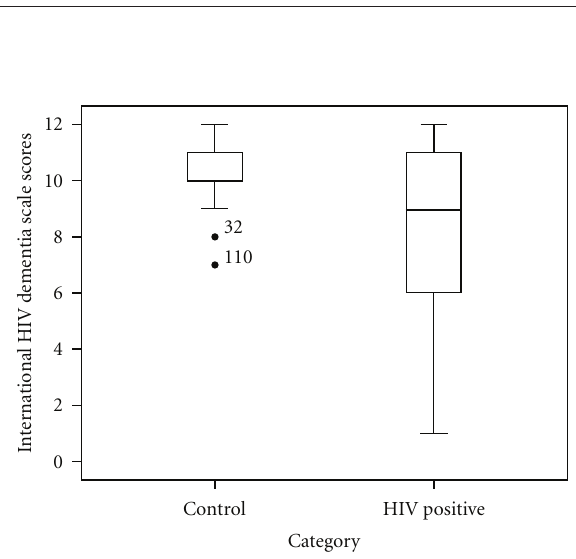
Figure 1: Comparison of MMSE scores in HIV-positive cases and HIV-negative controls. Box plot illustrating the distribution of MMSE scores in cases and controls. The mean ± SD) MMSE score of the controls (27 . 8 ± 1 . 3) and HIV-positive cases (27 . 7 ± 1 . 8) did not di ff er significantly (ANOVA; P = 0 . 59). Asterisked cases represent outliers within the HIV-positive group with MMSE scores below the group minimum.